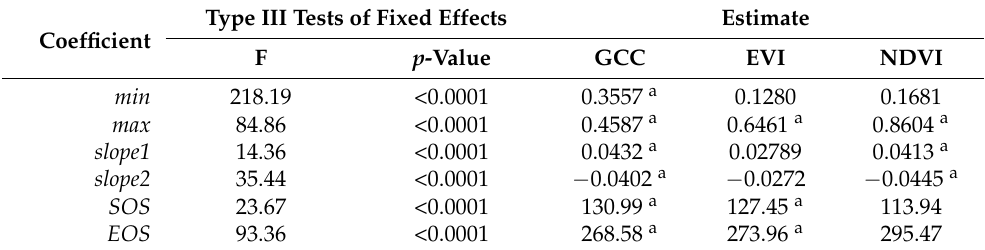
Table 3. Statistical parameters of MIXED model procedure based on phenological parameters of GCC, EVI, and NDVI curve fitting. “ a ” superscript indicates values significantly similar to each other at p <